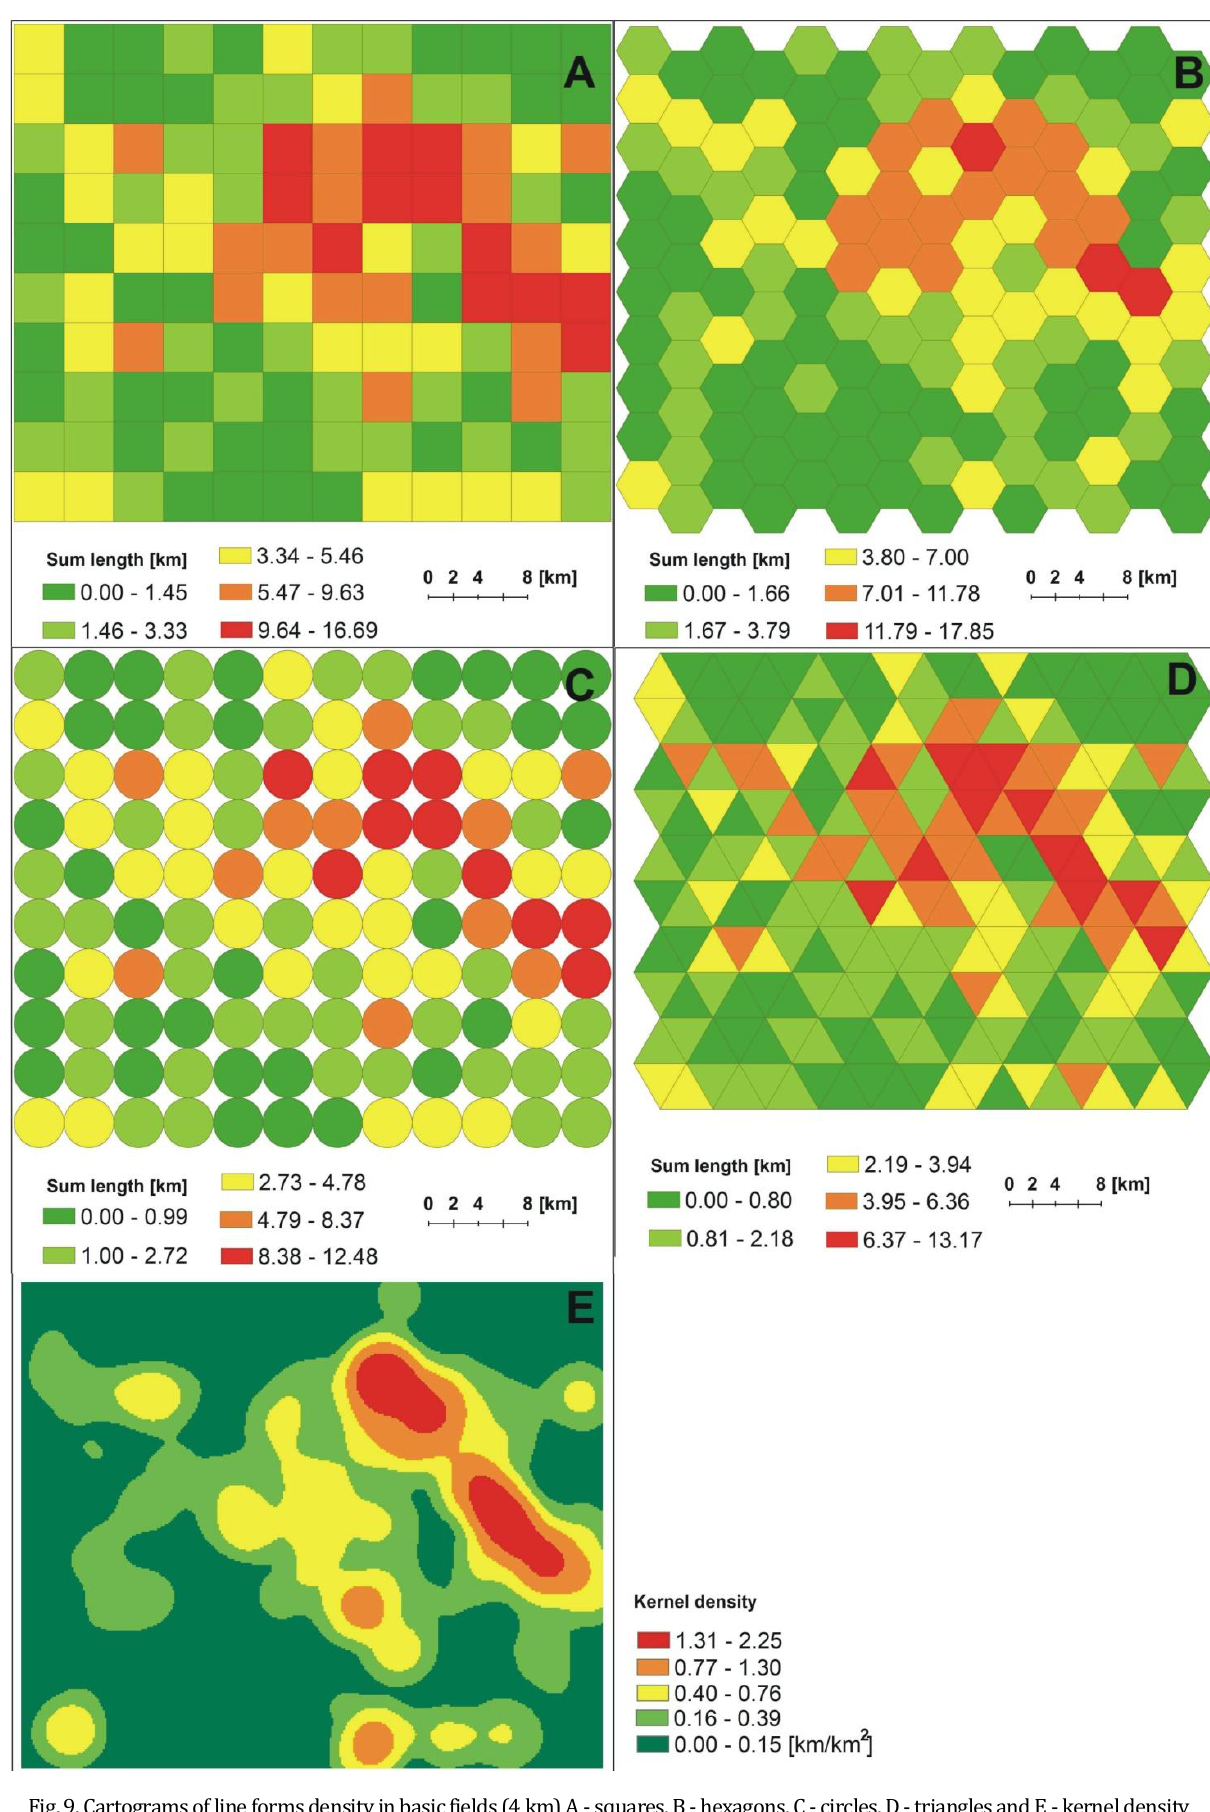
Fig. 9. Cartograms of line forms density in basic fields (4 km) A - squares, B - hexagons, C - circles, D - triangles and E - kernel